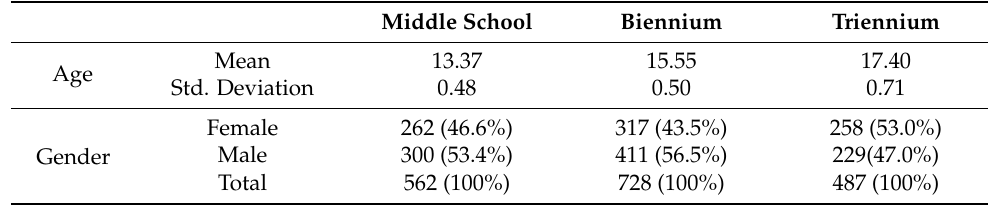
Table 1. Demographic